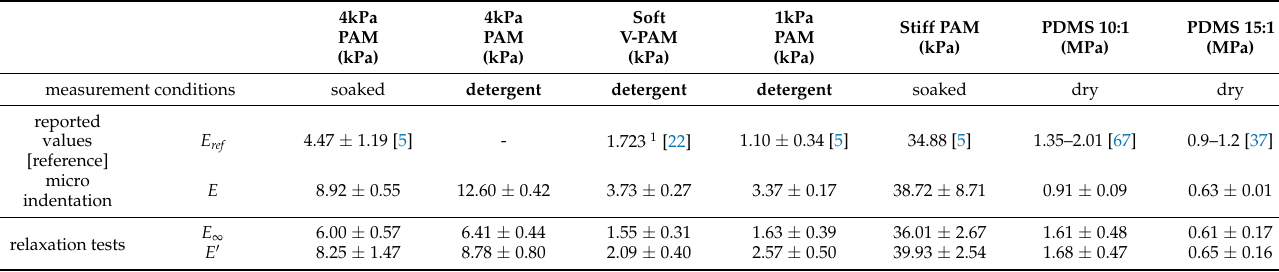
Table 1. Comparison of values of elastic moduli obtained for different methods, materials and conditions: E = calculated Young’s modulus, E ∞ = long-term stiffness, E (cid:48) = storage modulus evaluated at 1 Hz and E ref = reported Young’s modulus. Detergent and soaked are the conditions depicted in Figure 2 and dry is a condition for which the sample is not moistened and measured in air at room temperature. The JKR model was used to fit experimental data for soaked and dry samples, and the Hertz model was used for samples immersed detergent solution. All reported values are mean ± standard deviation for each condition (two samples were characterized in at least 6 different